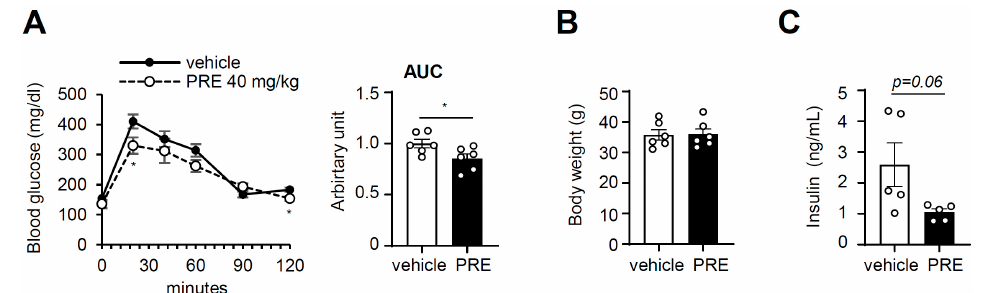
Figure 3. PRE improved glucose tolerance in diet-induced obese (DIO) mice. Seven-week-old male C57BL/6 mice were fed on HFD for 10 weeks, and then PRE was intraperitoneally administrated for a week. ( A ) Intraperitoneal glucose tolerance test (IPGTT) was performed as described in the experimental section. Body weight ( B ) and fasting insulin ( C ) levels were measured at the end of the experiment. Data are shown as the mean ± S.E.M. ( n = 6) * p < 0.05; ** p < 0.001; *** p < 0.0001 vs. HFD-fed vehicle group; AUC: area under the curve.